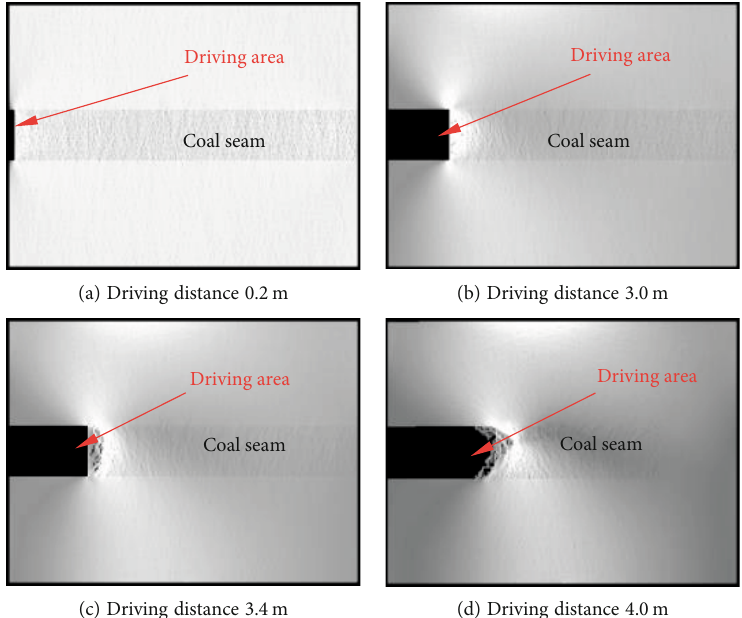
Figure 14: Evolution process of coal and gas outburst during coal roadway driving